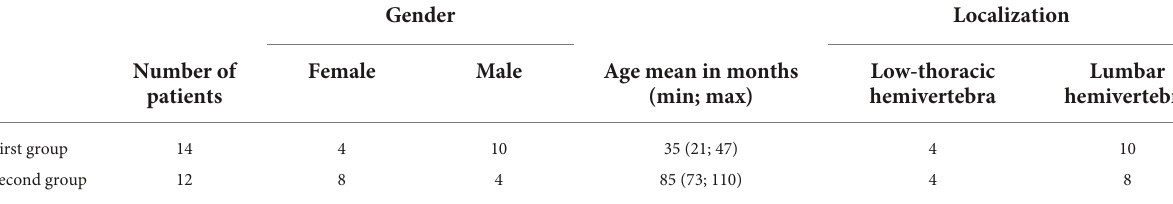
TABLE 1 Characteristics of the study groups by age, gender, and localization of the spinal malformation.